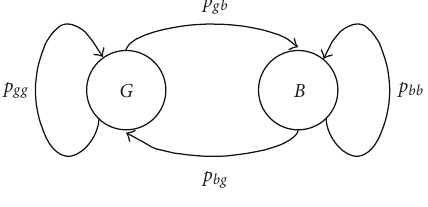
Figure 7: Gilbert-Elliot error